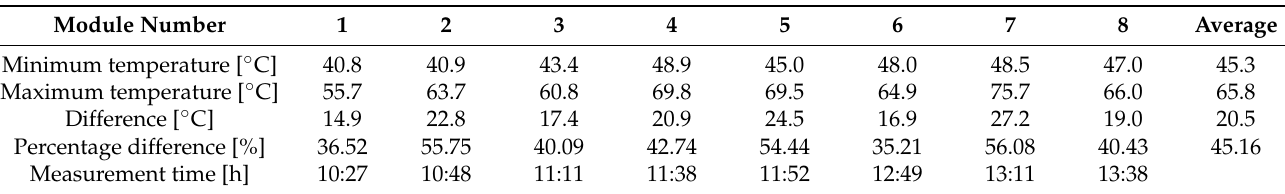
Table 13. Numerical data comparison of the thermographic analysis.